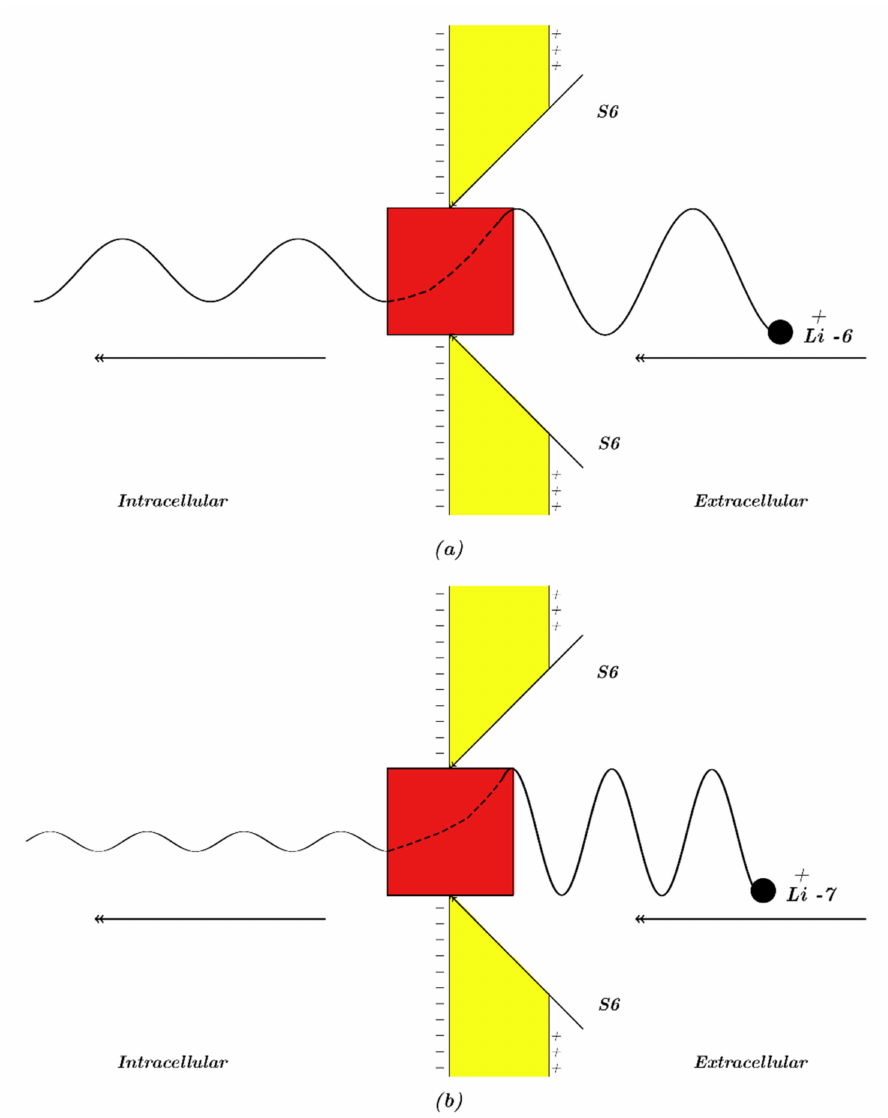
Figure 11. The figure represents a schematic diagram of the quantum tunneling of the extracellular lithium isotopes through the closed intracellular gate in which the dashed line represents the quantum tunneling process. ( a ): The quantum tunneling of the extracellular isotope Li-6. ( b ): The quantum tunneling of the extracellular isotope Li-7. The lithium isotope Li-6 has longer wave length and higher tunneling probability, which is represented by higher wave amplitude after passing the gate, while the lithium isotope Li-7 has shorter wave length and lower tunneling probability, which is represented by lower wave amplitude after passing the gate. The differences between the two isotopes in terms of wave length and wave amplitude after tunneling through the gate are attributed to the mass difference. In other words, the lower the mass, the longer the wave length and the higher the wave amplitude and vice